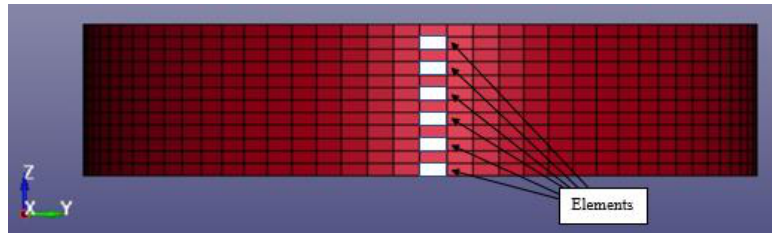
Figure 18. Location of the elements measured for equivalent stress. The variation of equivalent stress versus time for a blast intensity of 1500 kg TNT equivalent mass at standoff distances of 12.5 m and 25 m for different fill levels are